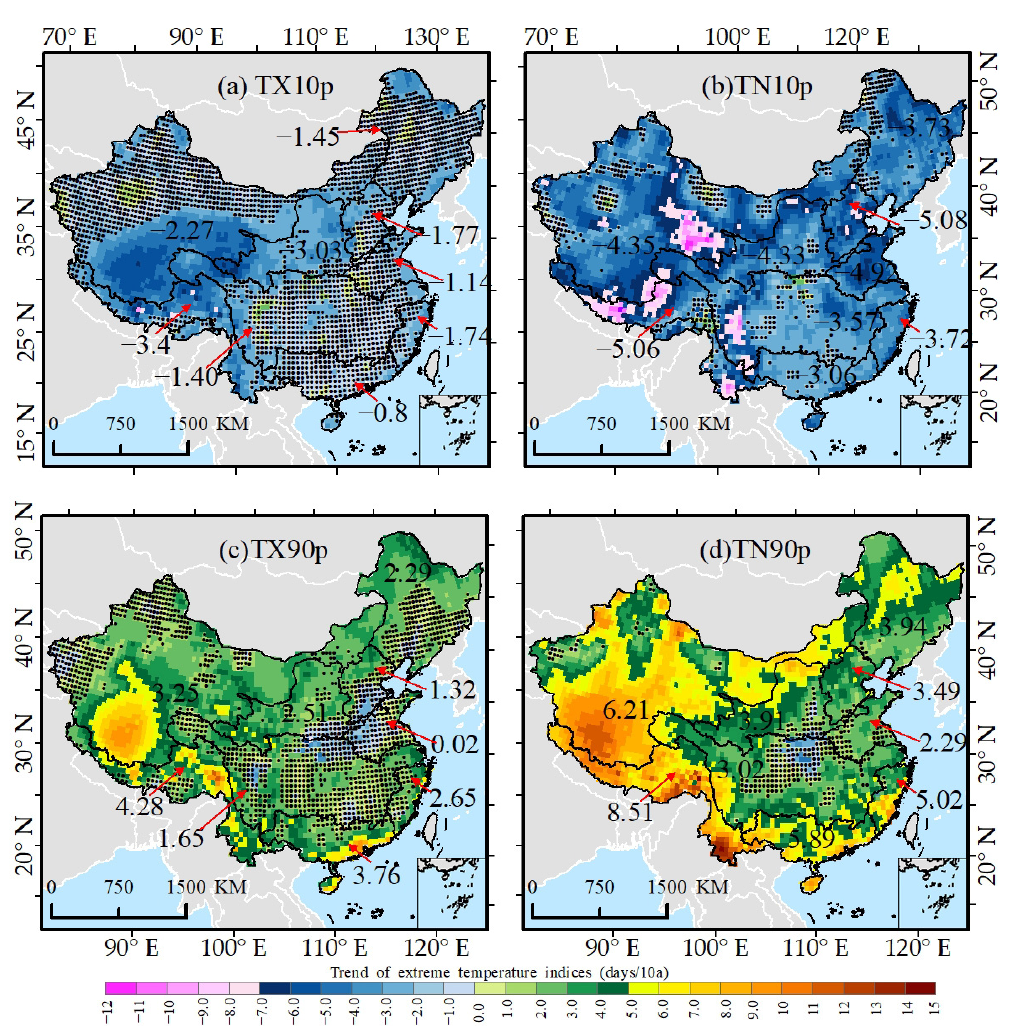
Figure 3. Spatial distribution of linear trend of ( a ) TX10p, ( b ) TN10p, ( c ) TX90p, ( d ) TN90p in main- land China during 1961–2013. The numbers in the map represent the trends of extreme temperature events in the corresponding basins, while black dots indicate that the trends are not significant, i.e., p > 0.05.